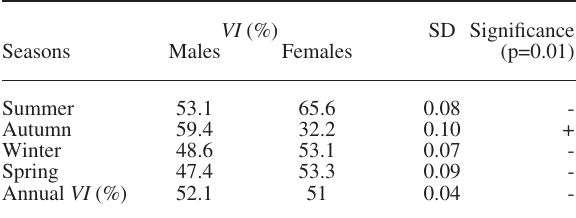
Table 3. – seasonal variations of the vacuity index ( VI ) of P. acarne and statistical comparison between males and females. sd: standard deviation.